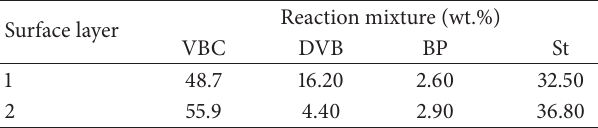
Table 1: Composition of reaction mixture for surface modification of PES